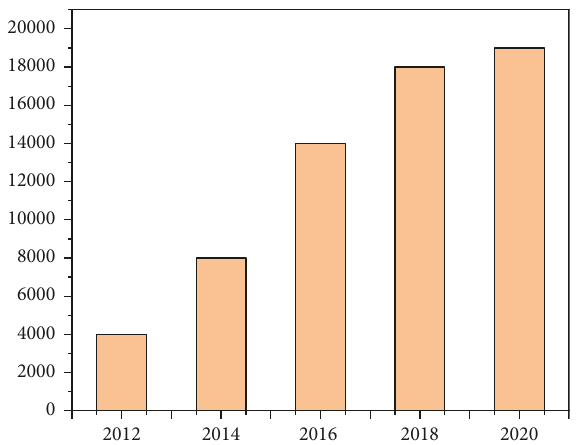
Figure 1: Statistical chart of automobile traffic accidents in China from 2010 to